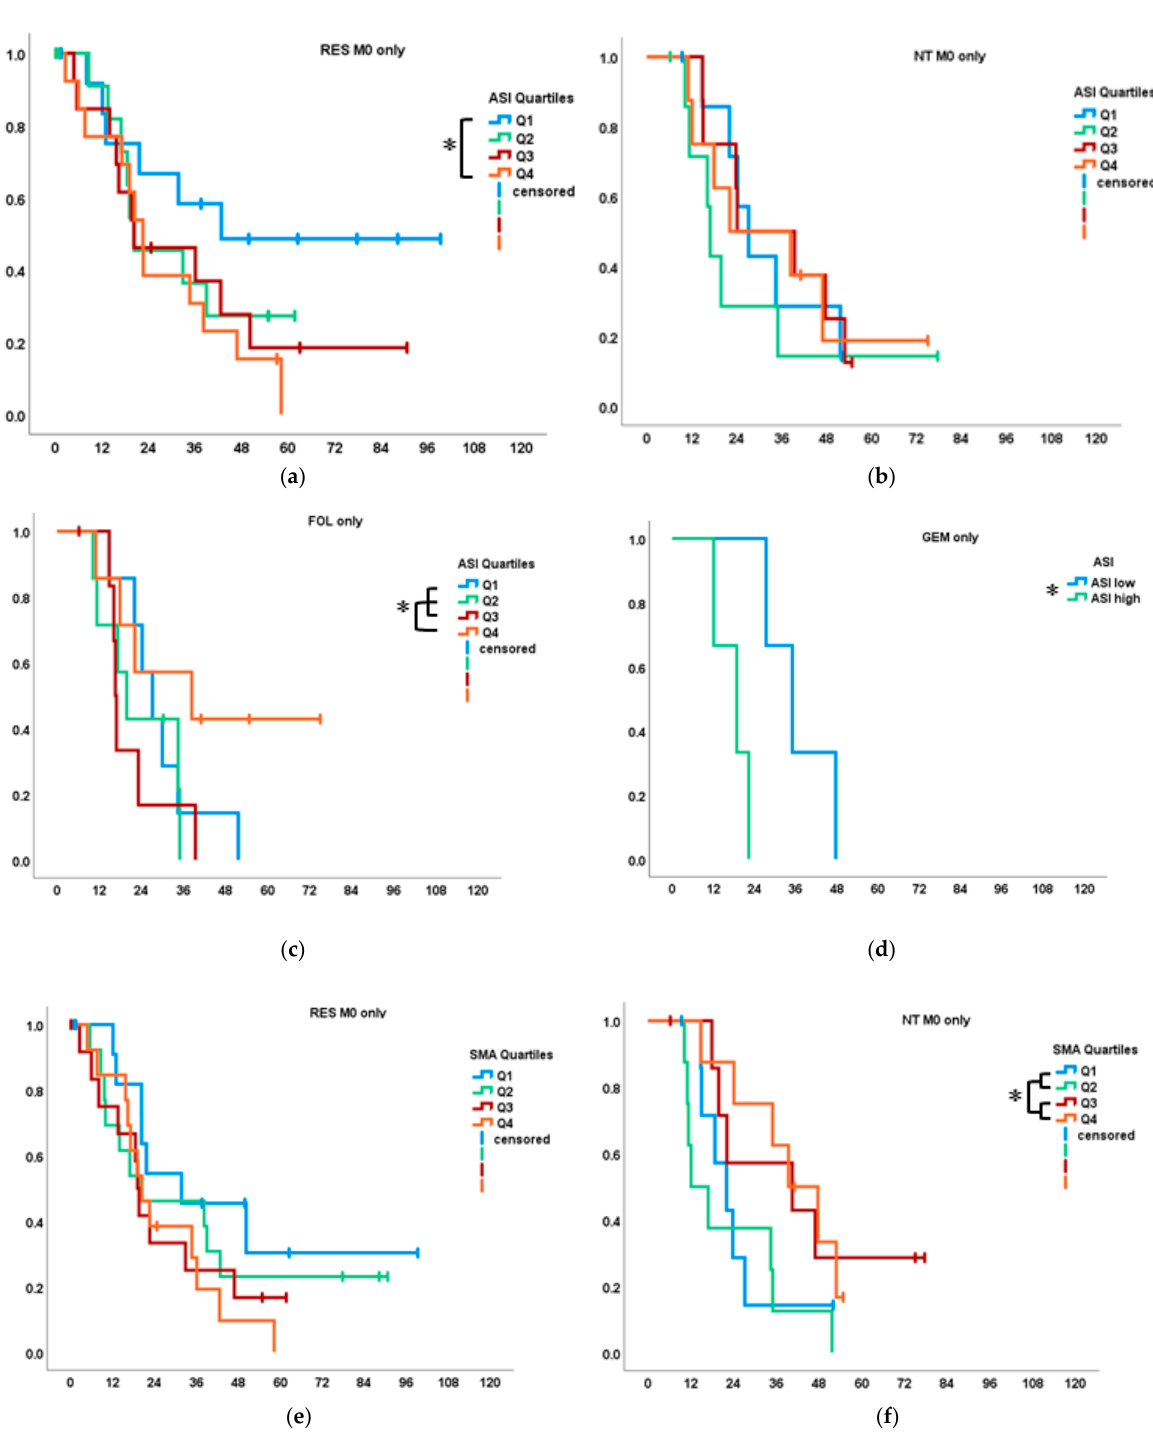
Figure 3 . Overall survival (OS; months) of subgroups by tissue parameter quartiles (Q). ( a ) OS of Figure 3. Overall survival (OS; months) of subgroups by tissue parameter quartiles (Q). ( a ) OS of Figure 2. ASI, α -SMA and AB values by type of neoadjuvant therapy. ◆ : ASI GEM vs. RES p = 0.032; RES M0 according to ASI; each Q n = 13 ( ✻ Q1 vs. Q4: p = 0.047); ( b ) OS of NT M0 according to GEM vs. FOL p = 0.048. ✻ : AB GEM vs. RES p = 0.015; GEM vs. FOL p = 0.015; GEM vs. COMB p = RES M0 according to ASI; each Q n = 13 ( Figure 2. ASI, α -SMA and AB values by type of neoadjuvant therapy. ◆ : ASI GEM vs. RES p = 0.032; ASI; each Q n = 8; ( c ) OS of FOL according to ASI; each Q n = 7 ( ✻ Q4 vs. Q1–3: p = 0.045); ( d ) OS of 0.025. Asterisks indicate outlier values (>1.5× IQR and <3× IQR); n = 5 extreme outliers clipped from GEM vs. FOL p = 0.048. ✻ : AB GEM vs. RES p = 0.015; GEM vs. FOL p = 0.015; GEM vs. COMB p = chart (>3× IQR; RES: 3.8/2.6; FOL: 3.9/2.4; GEM: 2.2). 0.025. Asterisks indicate outlier values (>1.5× IQR and <3× IQR); n = 5 extreme outliers clipped from Figure 2. ASI, α -SMA and AB values by type of neoadjuvant therapy. ◆ : ASI GEM vs. RES p = 0.032; chart (>3× IQR; RES: 3.8/2.6; FOL: 3.9/2.4; GEM: 2.2). GEM vs. FOL p = 0.048. ✻ : AB GEM vs. RES p = 0.015; GEM vs. FOL p = 0.015; GEM vs. COMB p = 0.025. Asterisks indicate outlier values (>1.5× IQR and <3× IQR); n = 5 extreme outliers clipped from chart (>3× IQR; RES: 3.8/2.6; FOL: 3.9/2.4; GEM: